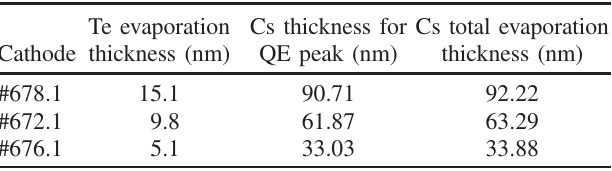
TABLE I. The evaporation thickness of the three fresh cathodes.